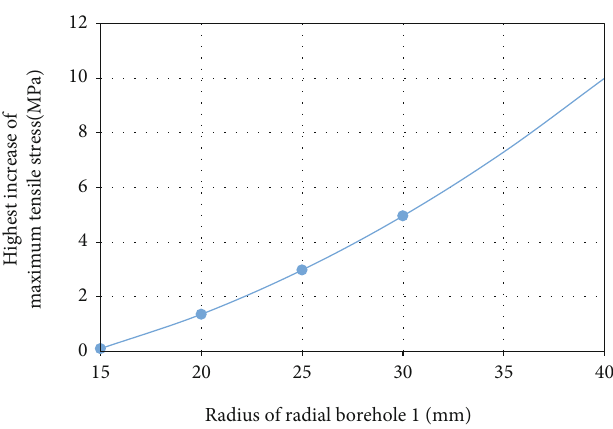
Figure 12: Highest increment of maximum tensile stress with di ff erent radius of radial borehole 1.